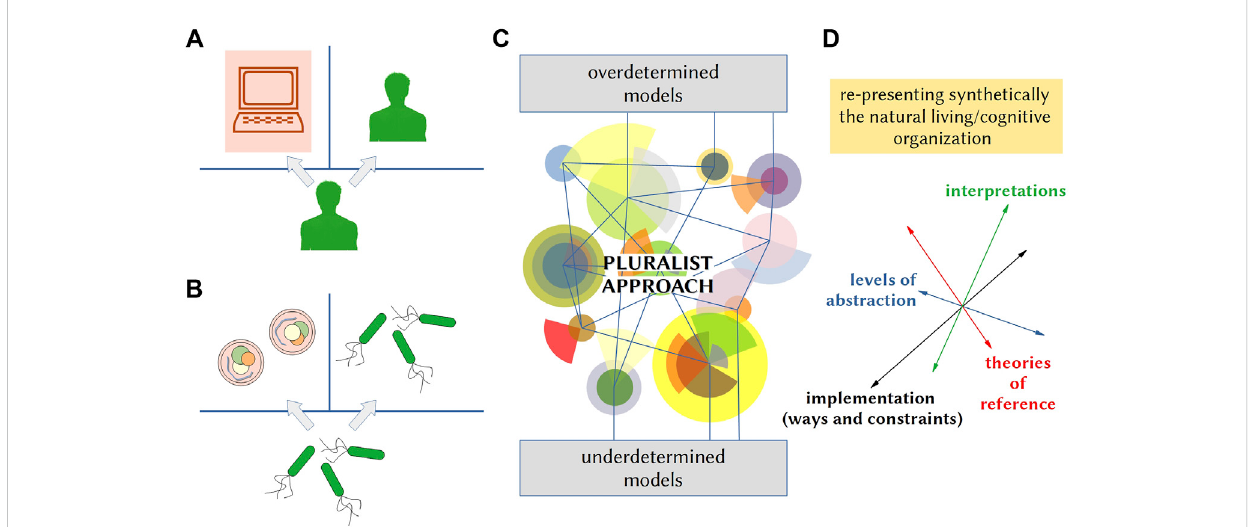
FIGURE 1 Problem of the relevance of synthetic (SB/SC) models. (A) Schematic representation of the classical version of the Turing test (Turing, 1950), also known as the imitation game. The test was devised to bypass the question “ can a machine think? ” or “ what is intelligence? ” and substitute it with an operationalde fi nition.Ahumaninterrogatorblindlyinteractswithacomputerorwithanotherhuman.Themachinebehaviorisde fi ned “ intelligent ” when the interrogator is not able to distinguish it from a human. The machine “ imitates ” human intelligence. (B) Schematic representation of the Turing testinaSBscenario(Croninetal.,2006).Livingcells(e.g.,bacteria)andSCshavesubstitutedhumansandcomputers.Chemicalsignalingorotherkindsof interactions substitute the written dialogs (questions/answers) on which the original Turing test is based. By analogy, the test can be considered a tool to bypass the question “ can a man-made chemical system be alive/cognitive? ” or “ what is life/cognition?, ” providing an operational de fi nition. A synthetic model of living/cognitive systems is alive/cognitive when living cells are not able to distinguish it from other living cells (more generally: when the syntheticmodelisbehaviorallyequivalent,forlivingcells,towhattheyperceiveanddynamicallyinteractwithastheirownenvironment). (C) Pictographic representation of the wide research space opened between underdetermined and overdetermined models, when a pluralist approach to the synthetic modeling of life and cognition is adopted. (D) Latter approach intends to overcome mere imitative modeling of life and cognition and proposes the scienti fi ccommunitytoattemptatrepresentingthebiological/cognitiveorganizationssyntheticallybyexploringavarietyoftheoriesofreference,diverse interpretationsofthesetheories,andmultipleoptionsavailablewithregardtothelevelsofabstraction,aswellastheways(andrelatedconstraints)oftheir